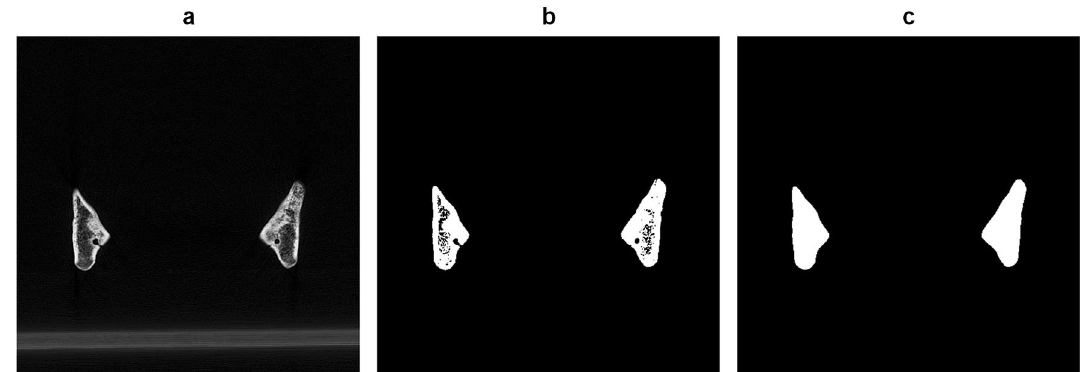
Figure 1. DICOM post-processing. Coronal DICOM slice ( a ), after segmentation ( b ), and after morphological closing and smoothing ( c ).